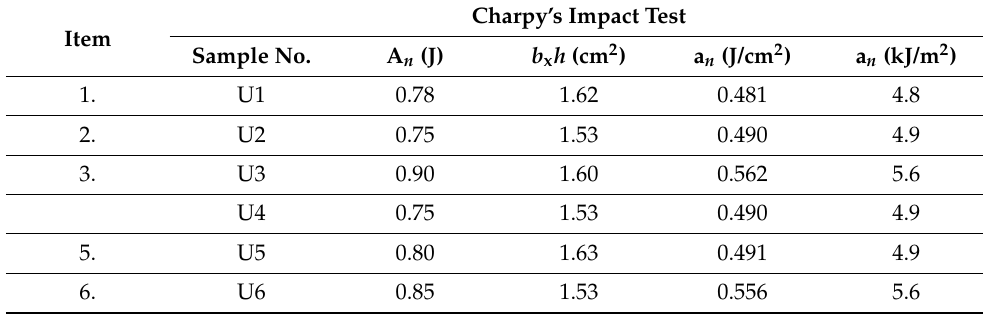
Table 4. Results of measurements and calculations of impact strength according to Charpy.